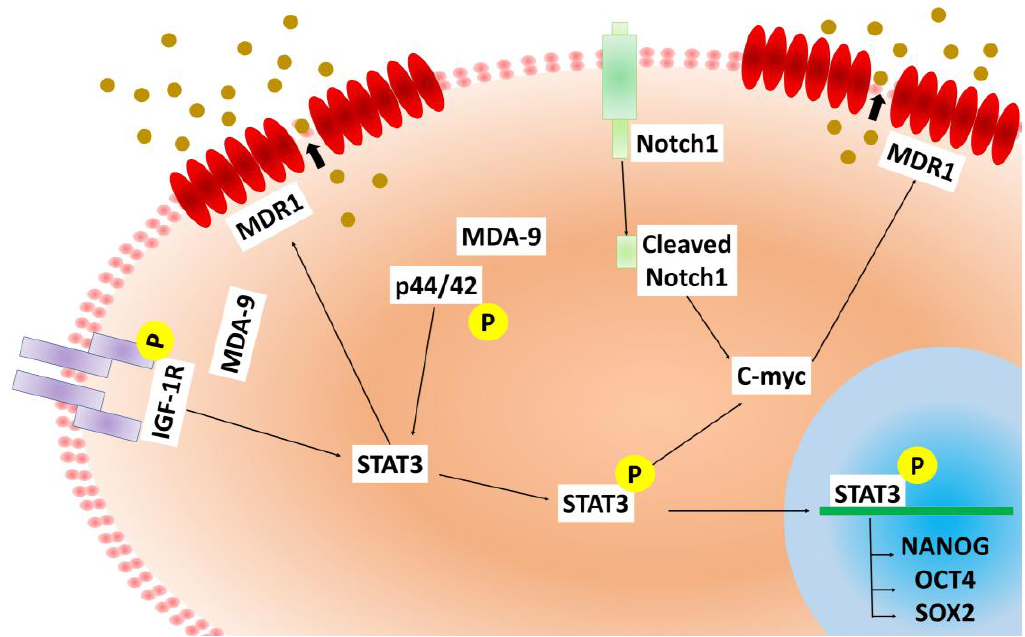
Figure 7. Schematic representation of MDA-9 mediated regulation of chemoresistance, in PCSCs. MDA-9 potentially regulates chemoresistance through IGF-1R/p44/42/STAT3/MDR1 and C-myc/MDR1 axis, and stem regulatory genes OCT4, Nanog and SOX-2 through STAT3.